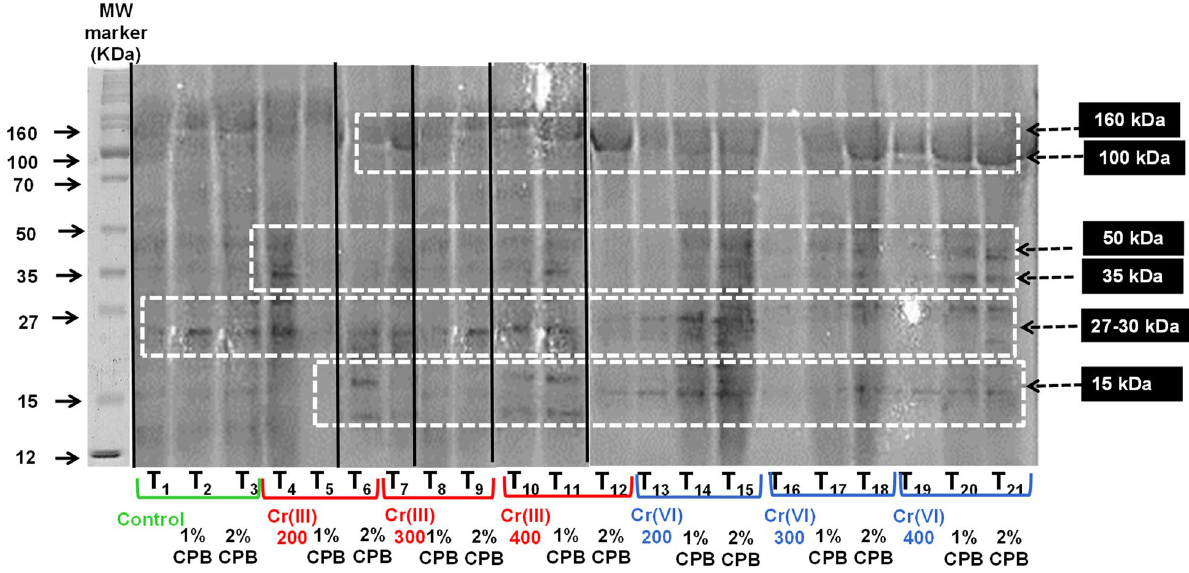
Figure 5. SDS-PAGE profile of tomato leaf due to the effect of soil amendment with plant biomass of Cloncurry buffel grass (CPB) under Cr(III) and Cr(VI) stress. The lanes report the MW marker, Molecular Weight protein ladder. T 1 : (Without Cr or CPB); T 2 : 1% CPB ; T 3 : 2% CPB mg/kg; T 4 : Cr(III) 200 mg/kg; T 5 :1% CPB + Cr(III) 200 mg/kg; T 6 : 2% CPB + Cr(III) 200 mg/kg; T 7 : Cr(III) 300 mg/kg; T 8 : 1% CPB + Cr(III) 300 mg/kg; T 9 : 2% CPB + Cr(III) 300 mg/kg;